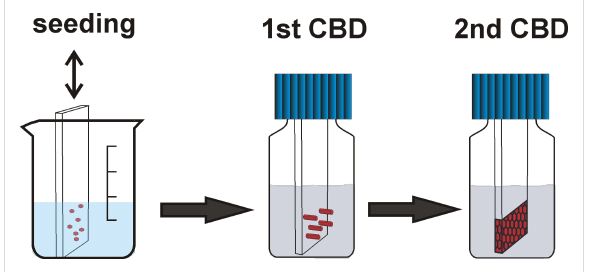
Figure 1: Scheme of the three-step, ZnO film deposition process. Seeds were deposited on glass slides by immersion in a Zn(II) solu- tion, followed by annealing. In the first CBD step, different ZnO morphologies can be grown depending on the time of the HYA addi- tion. In the second CBD step, a dense film can be